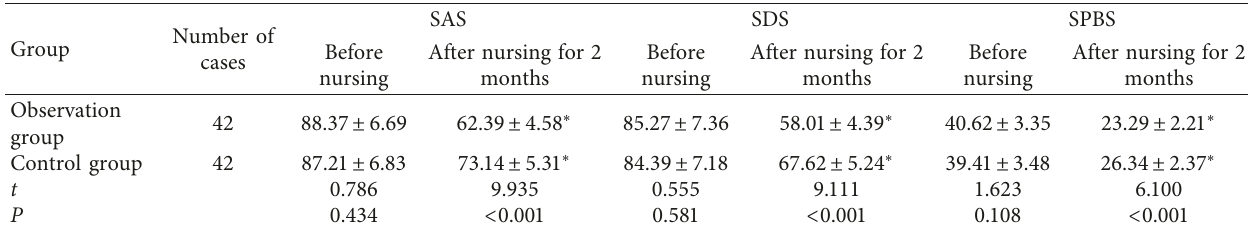
Table 5: Comparison of the psychological status between the observation group and the control group (score, x ± s